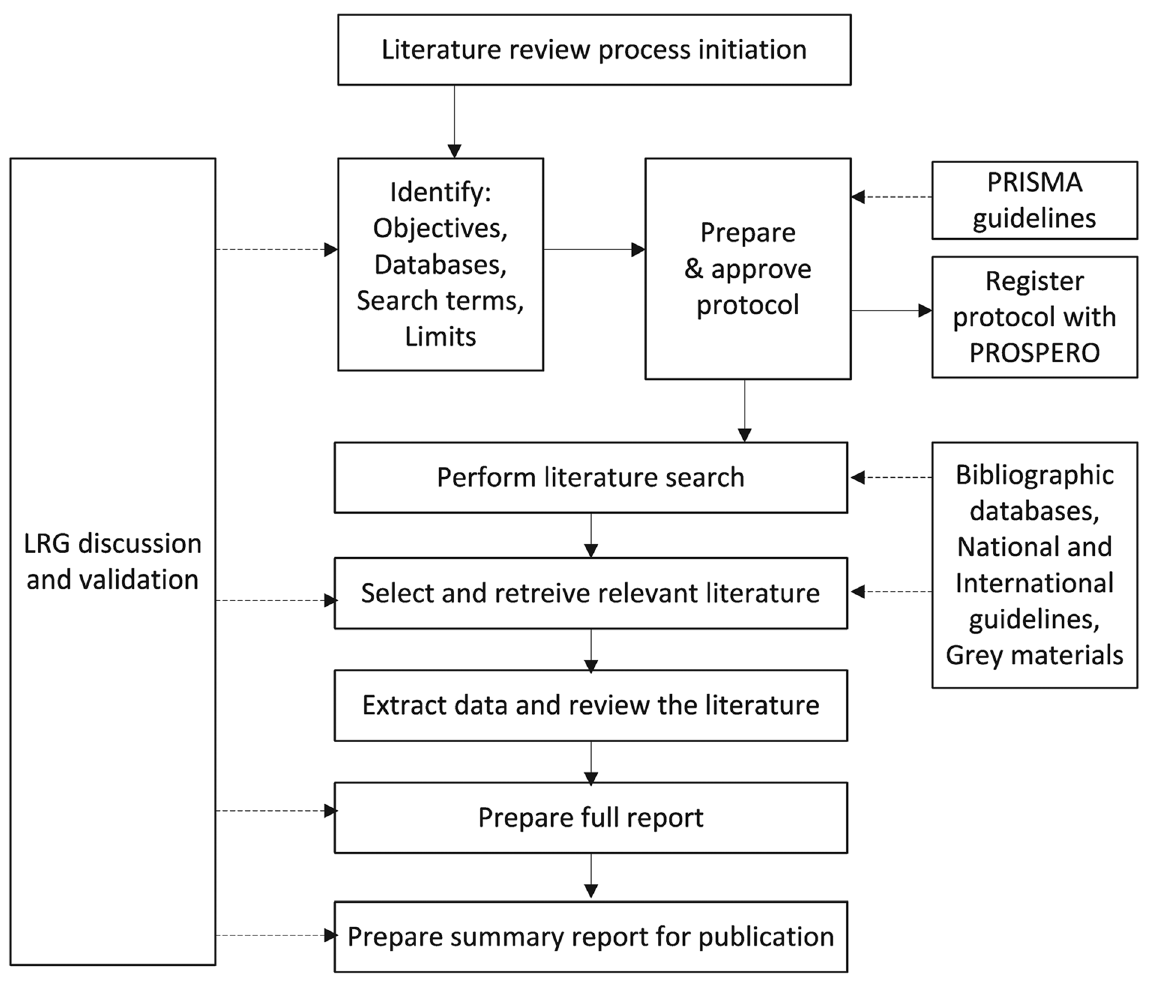
Figure 1. Project organisation and process of the seven national systematic literature review projects. Solid arrows illustrate sequential process steps; dashed arrows illustrate inputs into the process from the LRG or external sources.